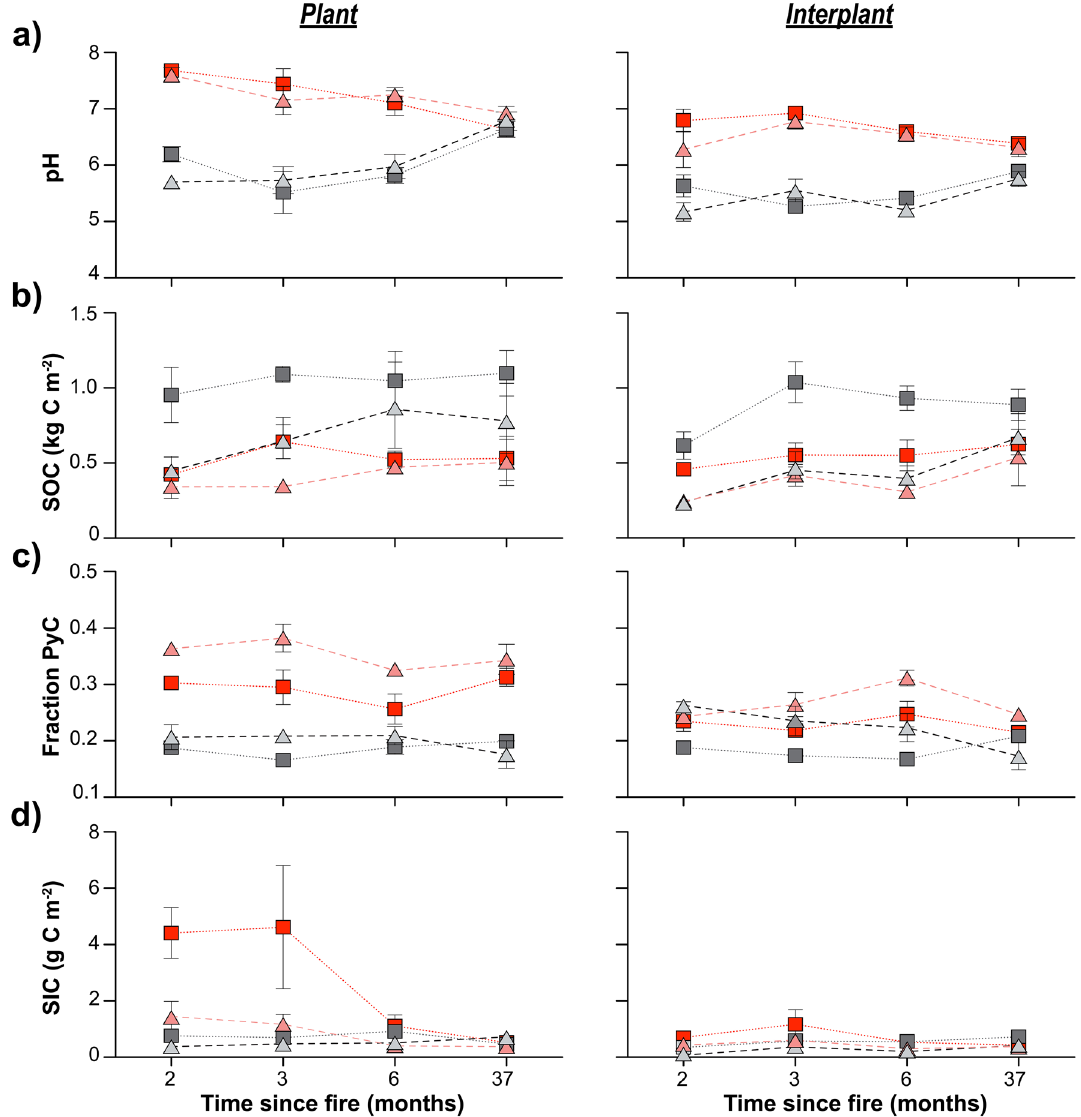
Figure 3. Soil properties exhibit scale-dependent responses and recoveries after fire. Comparison of ( a ) soil pH, ( b ) soil organic carbon (SOC), ( c ) fraction of pyrogenic carbon (PyC), and ( d ) soil inorganic carbon (SIC) on burned (red and pink) and control (dark and light grey) north- (squares) and south-facing aspects (triangles) 2–37 months after significantly higher than both controls (0.187–0.206) (p < 0.05). The increase in PyC was more modest but also significant in interplant spaces (burn: F 12 20.02, 0.008, aspect: F 12 15.49, 0.002). PyC did not vary with time and remained significantly elevated under previous plants and interplant spaces. In addition to PyC increases, we found that soil inorganic carbon (SIC) formed in largely carbonate-free soils either during or immediately after fire (Fig. 3d). Specifically, SIC increased significantly and preferentially under previous plants compared to interplant spaces, and it differed significantly with aspect, with significantly more SIC on north- than south-facing aspects (burn: F 1,12 31.61, p < 0.0001, aspect: 24.51, p = 0.003, burn-aspect, 16.08, p = 0.0017). 2 months after fire, SIC stocks in plant microsites were as high as 4.41 ± 0.90 g C m −2 and 1.4 ± 0.54 g C m −2 on burned north- and south-facing aspects, respectively. SIC was only marginally significantly elevated in burned interplant microsites (burn: F 1,12 4.38, p < 0.058, aspect: 13.3, p = 0.003, burn-aspect, 0.0003, p = 0.98) (Fig. 3d). SIC in plant microsites decreased significantly with time since fire and returned to background levels within 37 months (F 3,10 time: 17.92, p = 0.003, time x burn: F 3,10 21.17, p = 0.0001, time × aspect: F 3,10 7.63 p = 0.006, time × burn × aspect: F 3,10 5.67, p = 0.015). SIC appeared to form above a pH threshold of 6.5 (Fig. 4a). Post-fire carbonates (with enough mass to be run for isotopes, n = 6) revealed that the carbonate isotopes were markedly depleted in both δ 13 C and δ 18 O values compared to RCEW-CZO pedogenic soil carbonates formed at depth (Fig. 4b). Post -fire δ 13 C-carbonate values were correlated with SOC-δ 13 C values (Fig. 4c).